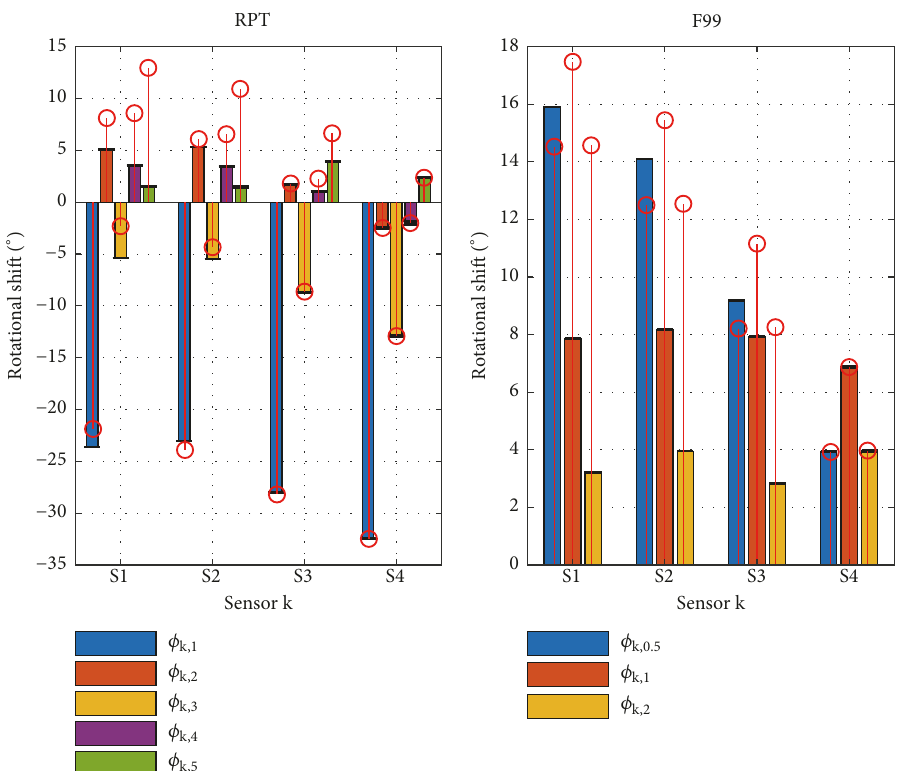
Figure 7: The angular shift from S4 to S1, S2, and S3 relative to runnerrotation. The theoretical shift according to the sensor position as shown in Figure 4 is indicated with the red stems. The theoretical shift is normalized to sensor position S4. The subscript k is the sensor number S1 to